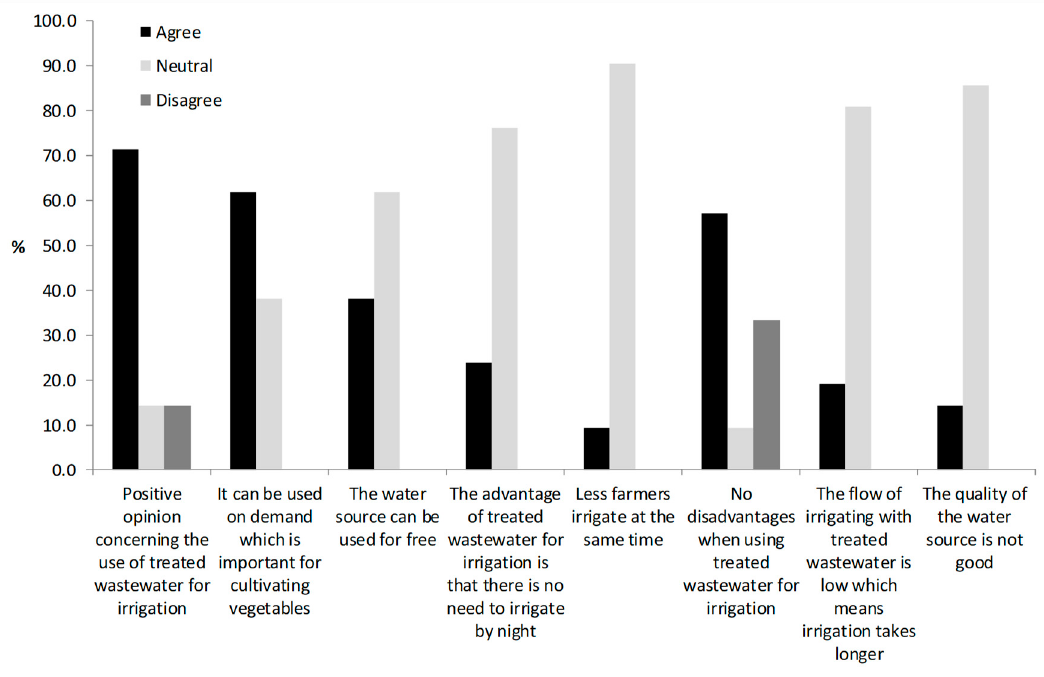
Figure 3. Farmers’ perception about the advantage and disadvantage of using treated waste-water for irrigation.